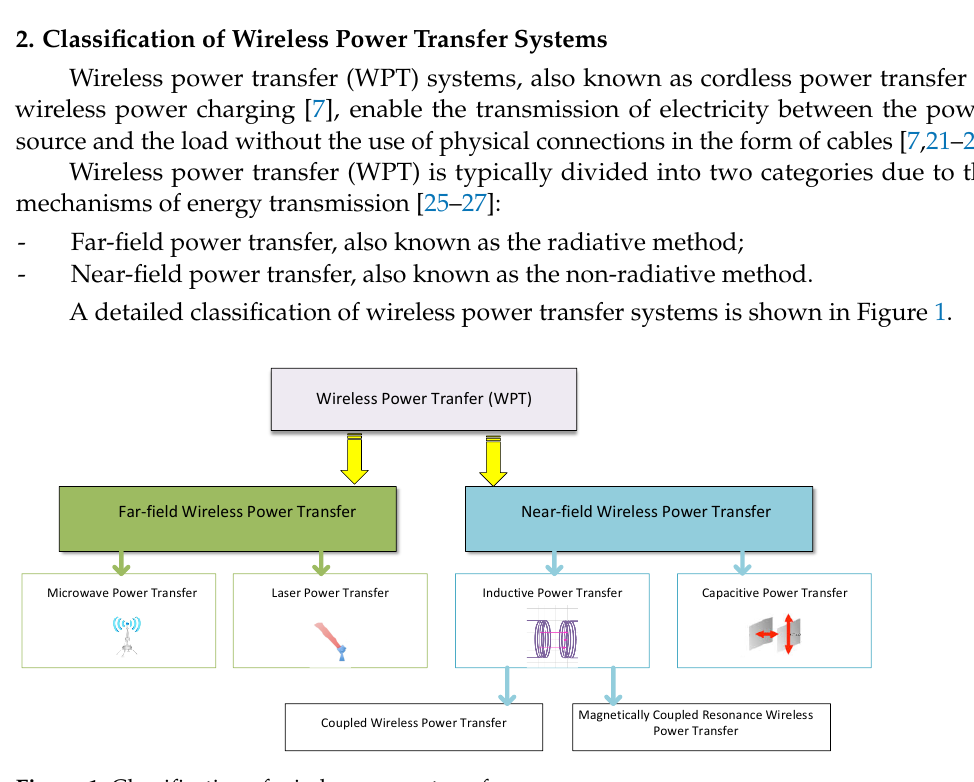
Figure 1. Classification of wireless power transfer.